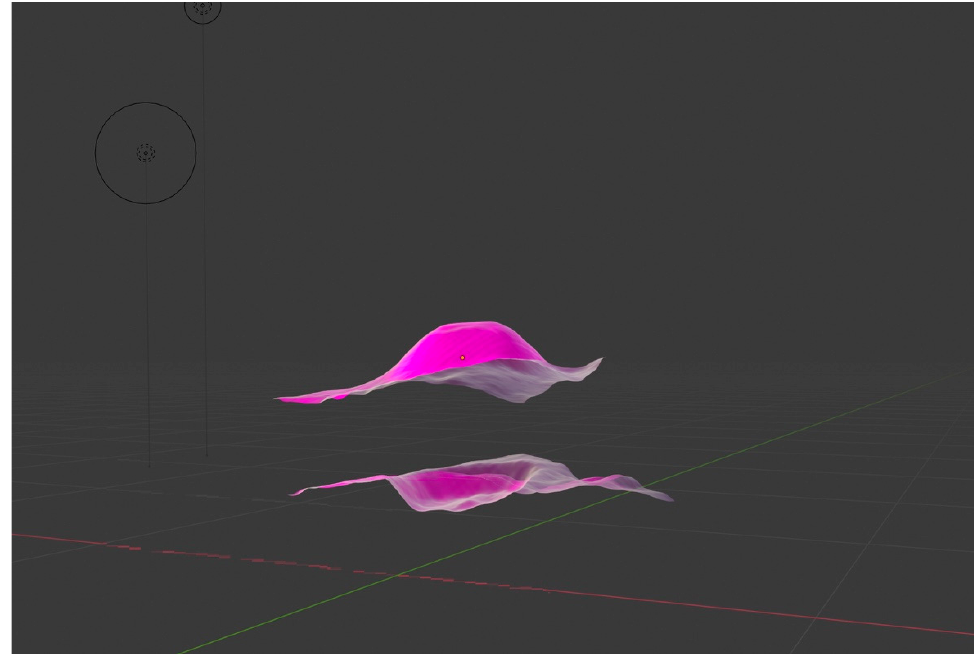
Figure 9. The 3D objects of Ahuna Mons (up) and Crater B (down) rendered in Blender 3D soft- ware.